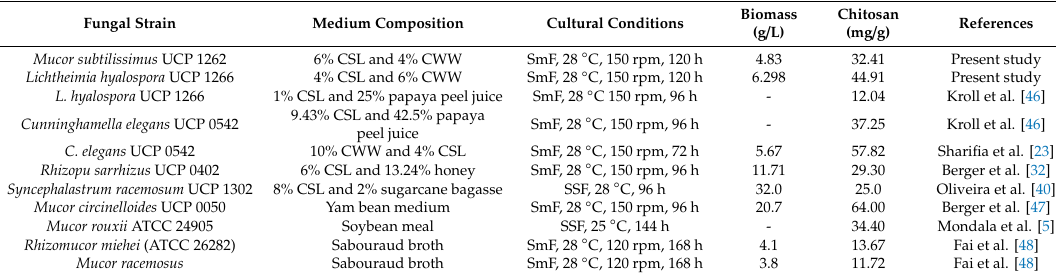
Table 4. Comparison of biomass and chitosan produced by Mucor subtilissimus UCP 1262 and Lichtheimia hyalospora UCP 1266 cultivated on agro-industrial substrates with the results described by the literature on Mucoralean fungi.